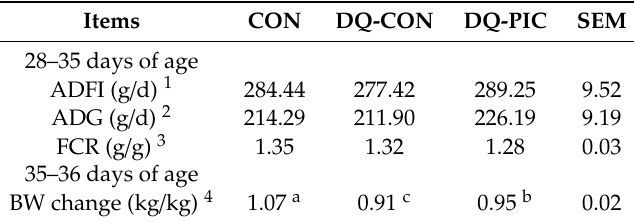
Table 3. E ff ects of piceatannol supplementation on average daily feed intake (ADFI), average daily gain (ADG) and feed conversion ratio (FCR) of diquat included piglets.